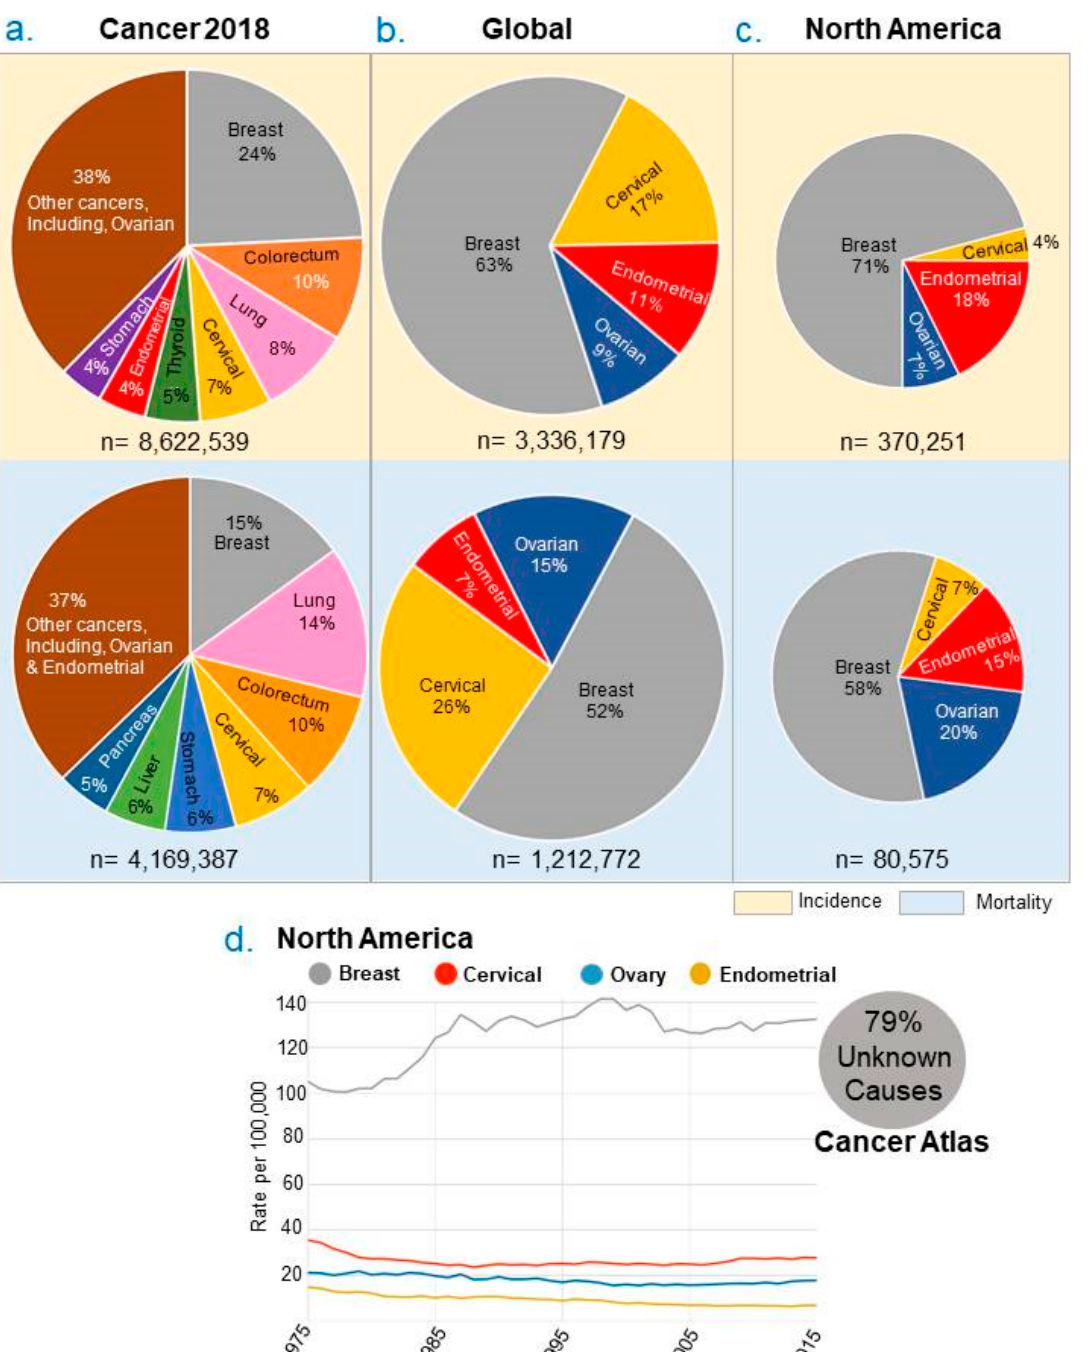
Figure 1. Incidence and mortality of women’s cancer. ( a , b ) Global incidence and mortality of breast, cervical, endometrial, and ovarian cancers [1–5]. ( c , d ) Incidence and mortality of breast, cervical, endometrial, and ovarian cancer in North America [1–5].